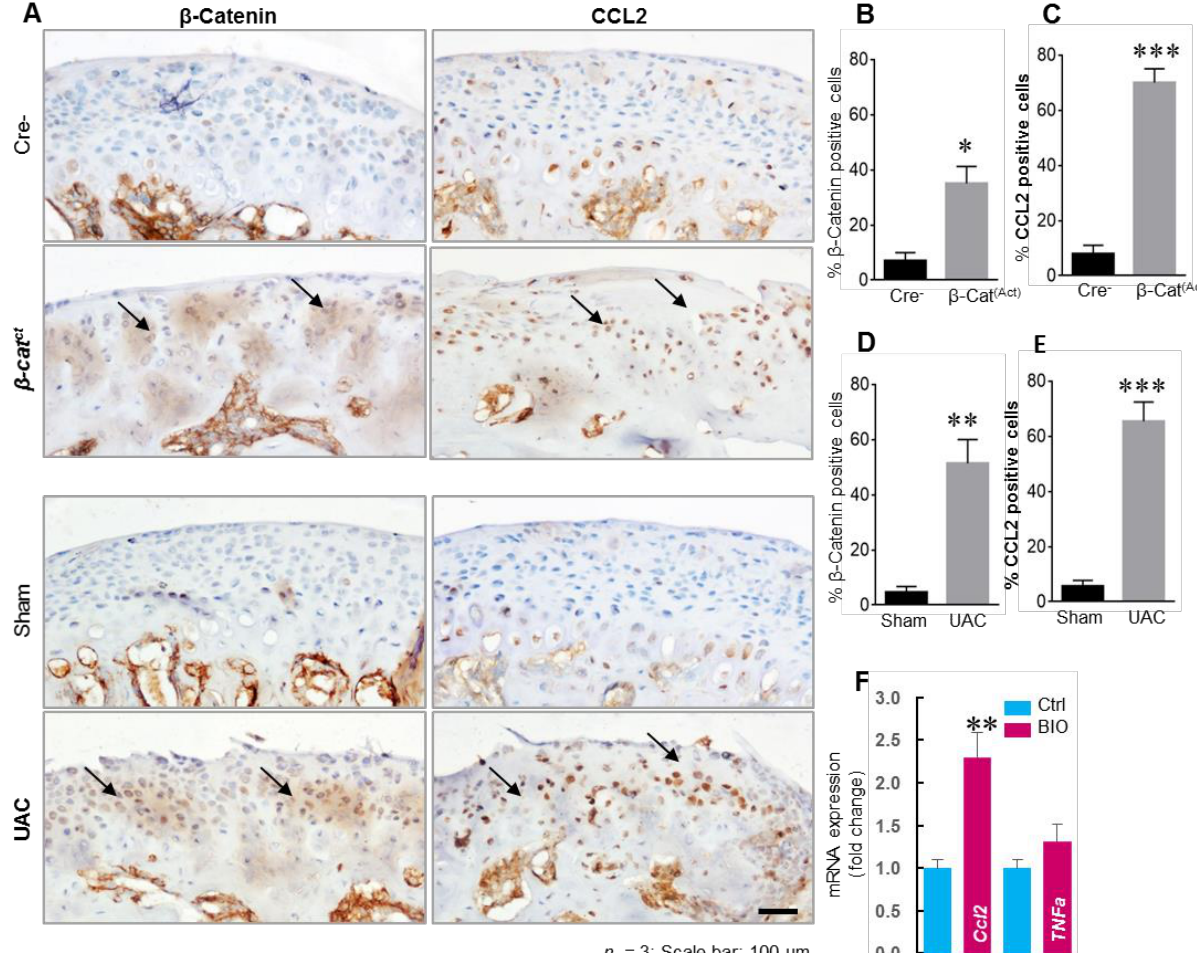
Figure 2. β -catenin and CCL2 expression increased in TMJ condylar fibrochondrocytes in TMJ OA mice and BIO upregulated Ccl2 expression in rat condylar fibrochondrocytes. ( A ) TMJ tissues from β -catAct and Cre-mice were collected at the ages of 8-week-old for IHC analysis. The TMJ tissues of WT (C57BL/6) mice were also harvested 3 weeks after UAC operation for IHC analysis. Results showed that the levels of β -catenin and CCL2 increased in β -catAct mice compared to Cre-mice, and the same results were also shown in UAC-induced TMJ OA mice. Black arrows represent the typical positive expression cells in TMJ cartilage tissue. ( B – E ) Cells with positive staining for β -catenin and CCL2 were quantified ( n = 3). Identically significant upregulation of CCL2 expression was also indicated in both β -catAct mice and UAC-induced TMJ OA mice. ( F ) Rat TMJ condylar fibrochondrocytes were treated with GSK-3 β inhibitor, BIO, for 24 h. BIO (1 µ M) significantly upregulated Ccl2 expression in TMJ condylar fibrochondrocytes and increased β -catenin protein level (Supplementary Figure S1). Statistical analysis was conducted using an unpaired t test. * p < 0.05, ** p < 0.01, *** p <